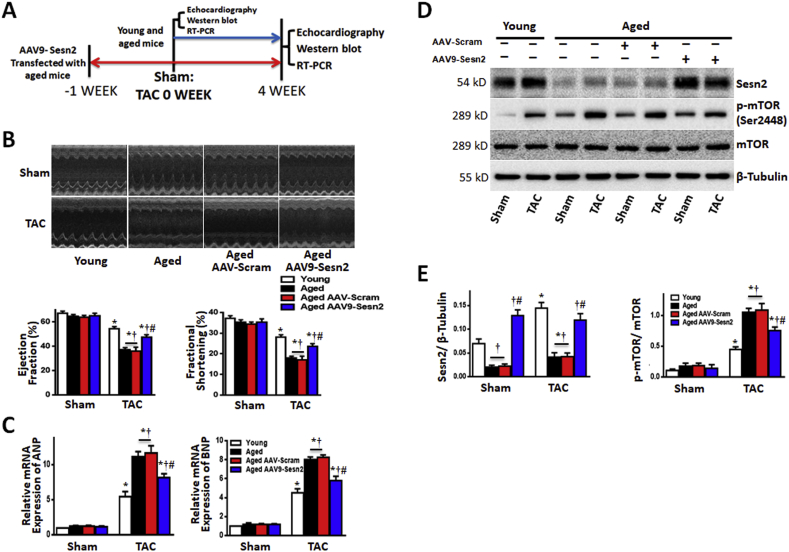
Sesn2 rescue in aged hearts ameliorates pressure overload-induced cardiac hypertrophy. (A) Experimental design: aged WT(Aged) mice were treated with AAV9-Sesn2 at 1 week before TAC. Heart function was monitored by ultrasonography and heart tissues were harvested at indicated time points for immunoblotting and qPCR. (B) Echocardiography showed that AAV9-Sesn2 treatment improved resistance of aged heart to TAC, as demonstrated by EF and FS (n = 6–15 per group). (C) Expression analysis of ANP and BNP (n = 5–6 per group). (D) Immunoblot for Sesn2, phospho-mammalian target of rapamycin (p-mTOR), and mTOR from hearts of sham or TAC operated young WT and aged WT mice, treated with or without AAV9-Sesn2 as indicated in panel A. (E) Quantification of immunoblot shown in panel D (n = 5–6 per group). Values are mean ± SEM, *p < 0.05 vs. Sham group; #p < 0.05 vs. corresponding young group; †p < 0.05 vs. corresponding aged group.